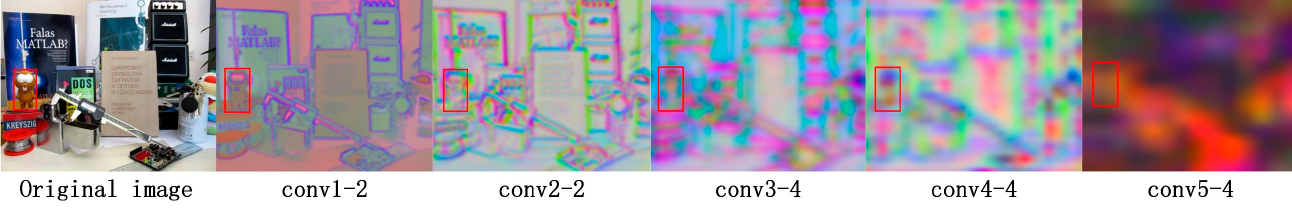
Figure 1. Visualization of the “lemming” image with features extracted on the five convolutional layers, conv1–2, conv2–2, conv3–4, conv4–4, and conv5–4, in VGGnet-19.